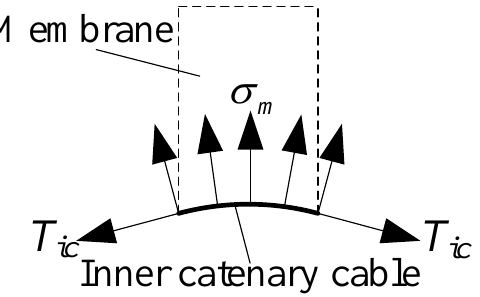
Figure 5. Extraction diagram of web-like tensioned membrane